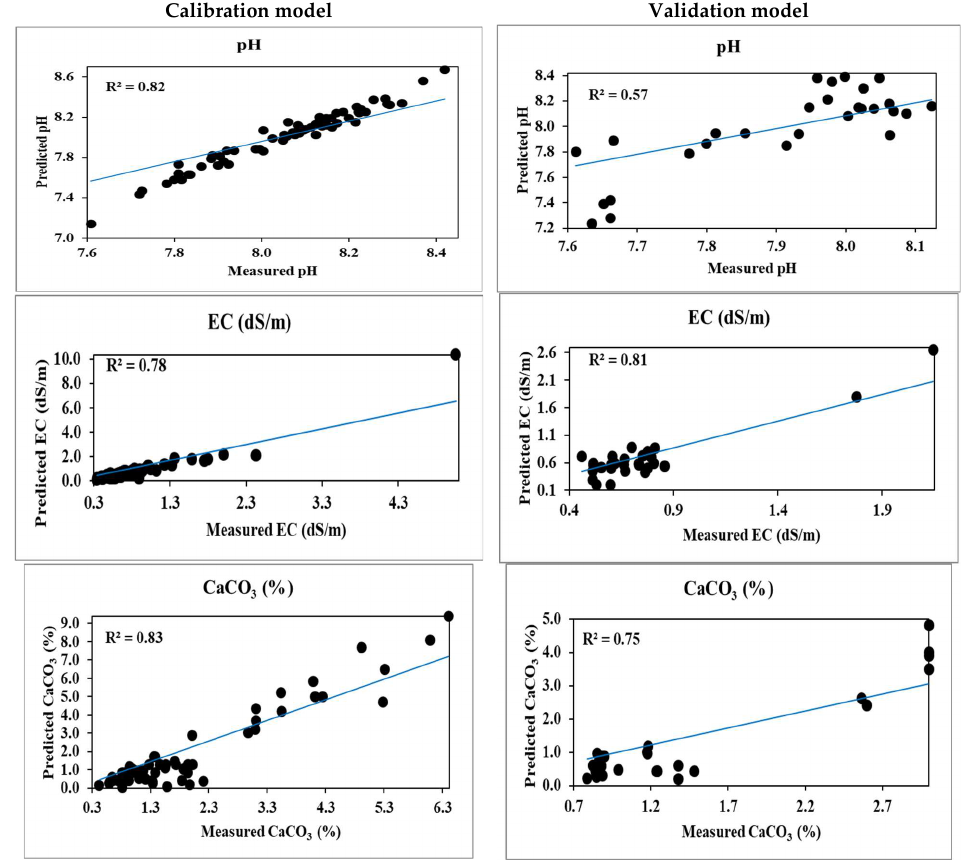
Figure 8. RF calibration and validation of soil parameters.